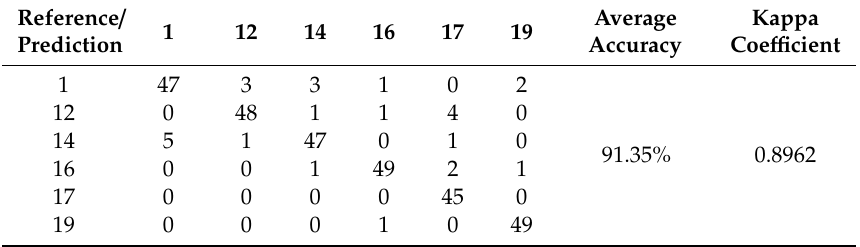
Table 7. Confusion Matrix using the SVM classifier in zones 1, 12, 14, 16, 17 and 19.